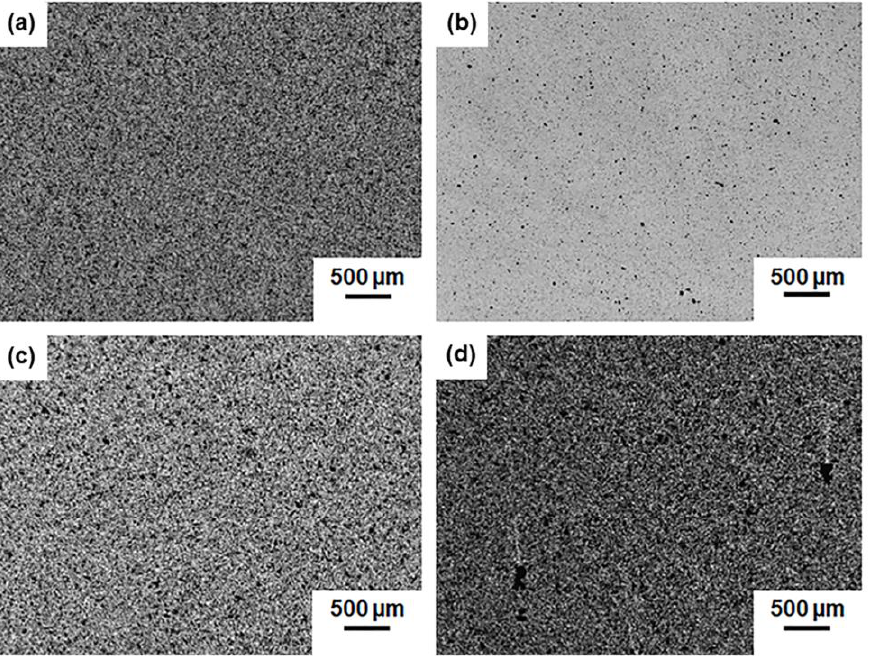
Figure 1. Optical images of ( a ) epoxy/GNP AO-4 (I d = 0.532 ± 0.008), ( b ) epoxy/xGNP-C750 (I d = 0.509 ± 0.015), ( c ) epoxy/xGNP-H5 (I d = 0.478 ± 0.018) and ( d ) epoxy/xGNP-M5 (I d = 0.437 ± 0.013) mixtures after sonication in ultrasonic bath at 80 °C for 90 min.